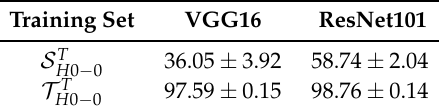
. Average and standard H 0 − 0 ). H 0 − 0